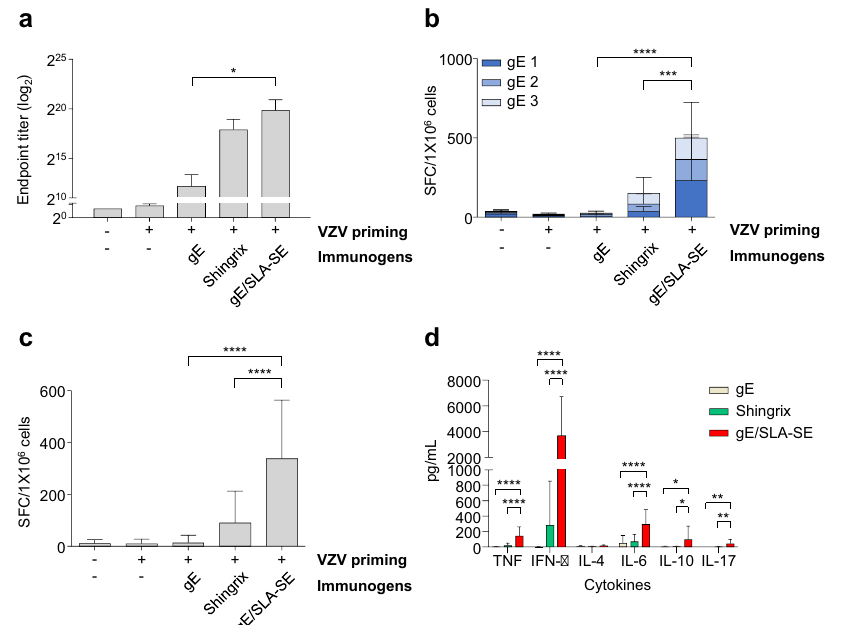
Fig. 3 gE- or VZV-speci fi c immune responses induced by gE/SLA-SE or Shingrix in elderly mice. Eighteen-month-old mice were primed with live attenuated VZV and immunized twice with gE (5 μg), gE (5 μg)/SLA-SE (10 μg SLA in 2% oil), or Shingrix (1/10 human dose, gE [5 μg]/ AS01 B [5 μg MPL and 5 μg QS21]) at a 4-week interval. Four weeks after the second immunization, serum was obtained from immunized mice to examine humoral immunity and spleen cells prepared to examine antigen-speci fi c cell-mediated immunity. a gE-speci fi c total IgG endpoint antibody titer (log 2 transformed) using serum from immunized mice. b , c Detection of antigen-speci fi c IFN- γ -secreting T-cell numbers by mouse IFN- γ ELISPOT assay using spleen cells from immunized mice upon ex vivo stimulation with ( b ) three pools of 62 gE OLPs (15-mer, 5-mer overlap): gE 1 (20 peptides), gE 2 (20 peptides), and gE 3 (22 peptides) or ( c ) VZV-infected cell lysate. d Measurement of cytokine secretion upon stimulation with gE OLP by cytometric bead array assay. Data are pooled from two independent experiments and presented as individual data points with means and standard deviations. * P < 0.05, ** P < 0.01, *** P < 0.005, **** P < 0.001 (ordinary one-way ANOVA). n = 4-6 (control), 8 – 10 mice per